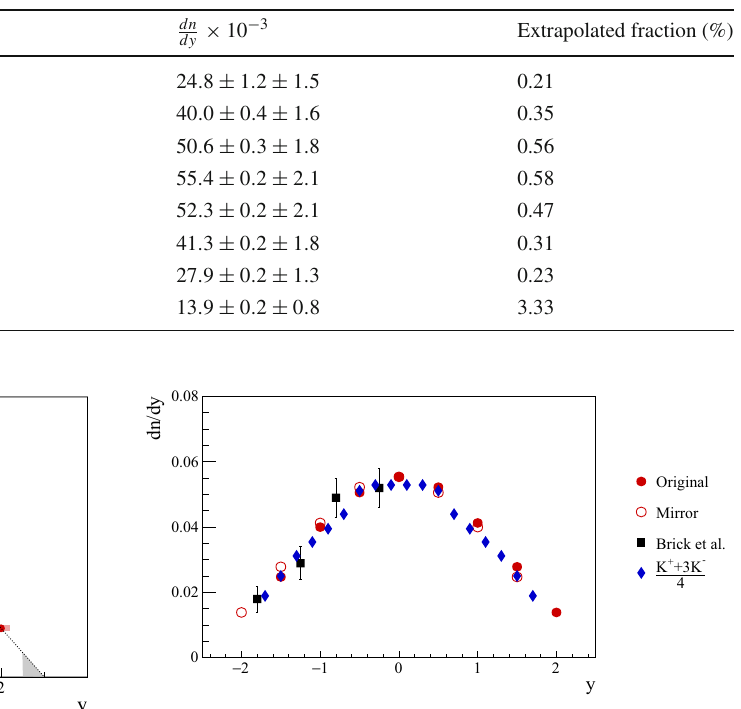
Table 3 First column shows the rapidity range. In the second column thevaluesoftheinverseslopeparameterarelistedwithitsstatisticaland systematic uncertainties. The third column shows the numerical values